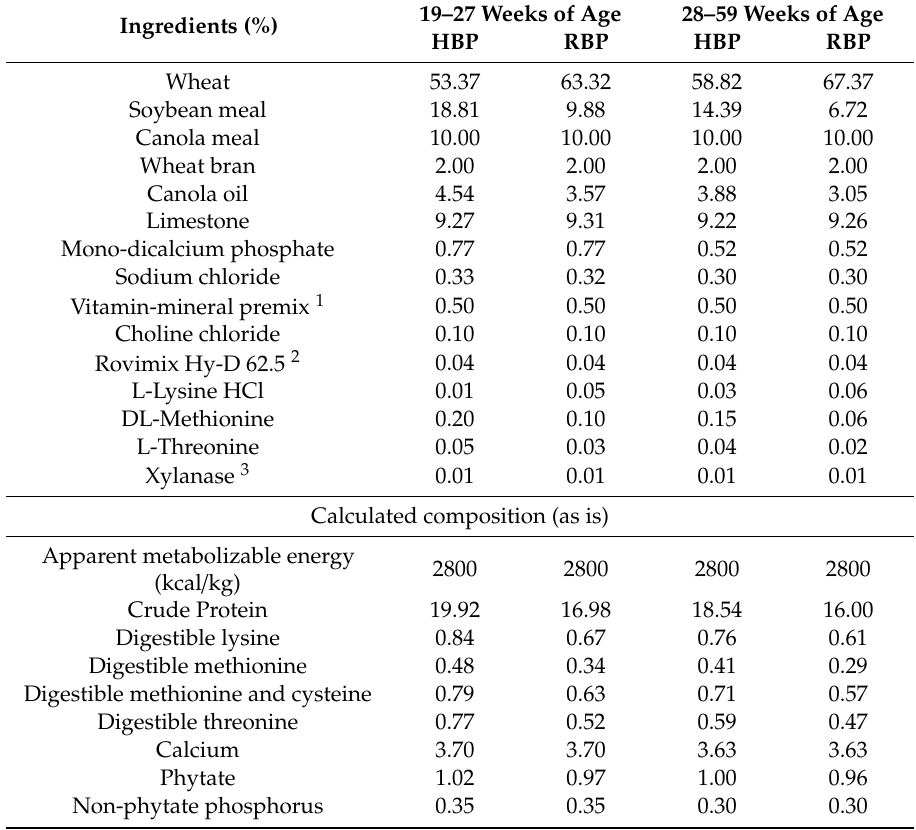
Table 1. Ingredients and calculated composition of high balance protein (HBP) and reduced balance protein (RBP)